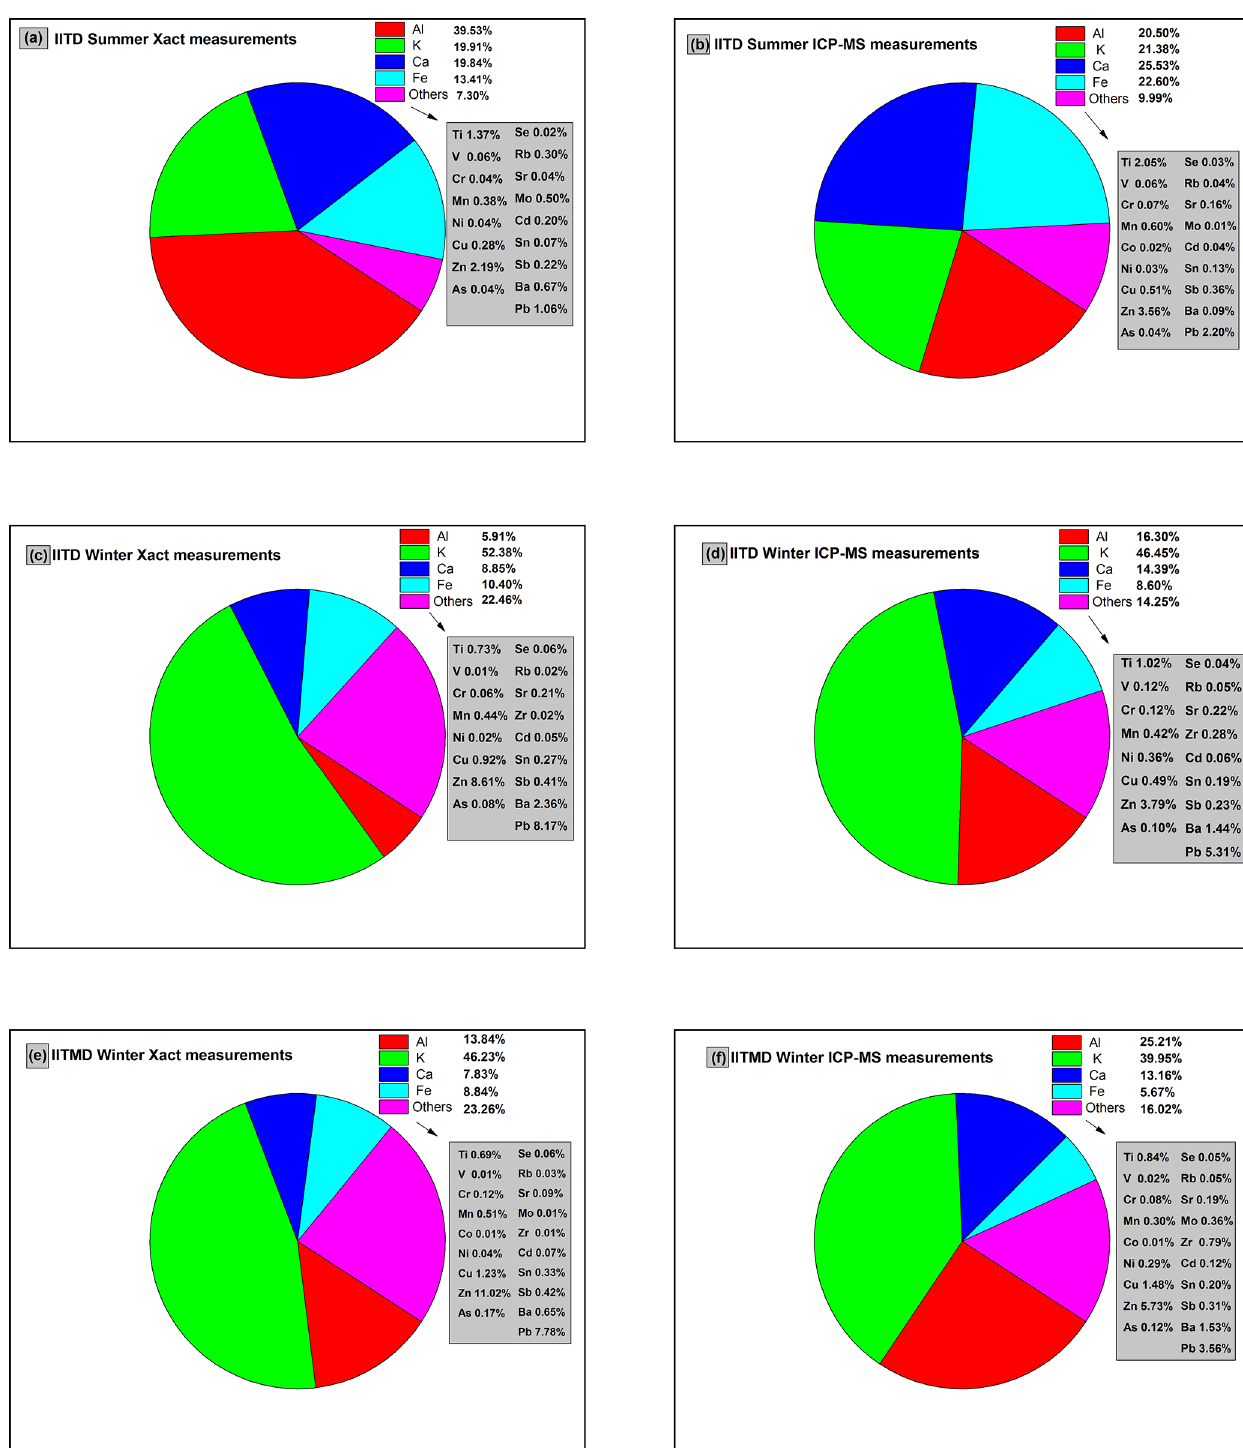
Figure 5. Fractions (%) of elements in the total element concentration in PM 2 . 5 presented in pie format for online (a, c, e) and offline (b, d, f) measurements during winter and summer at IITD and during winter at